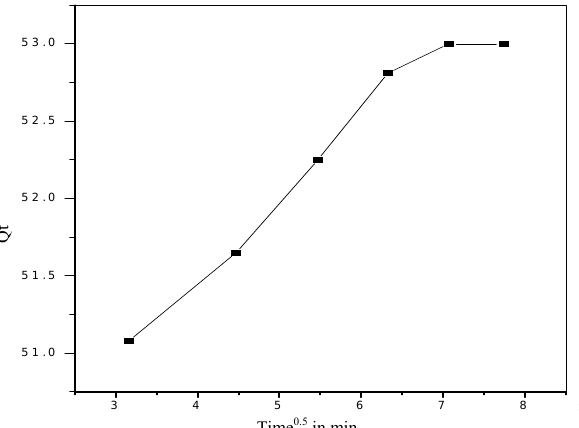
Figure 6. Intra-particle diffusion effect for the adsorption of copper ion by CBC [Cu]=30 mg/L;